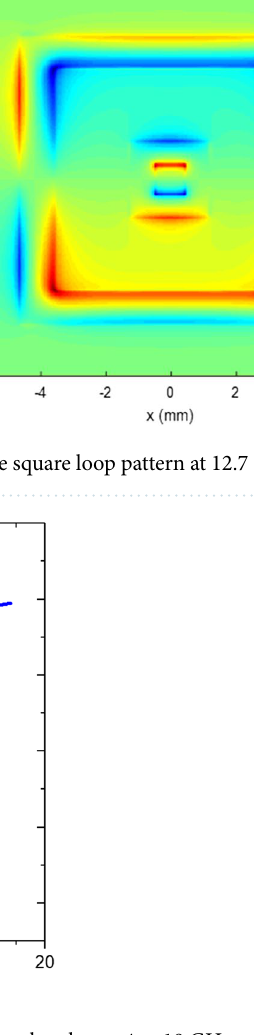
Figure 4. Simulated RCS reduction of the designed microwave absorber at 4 to 18